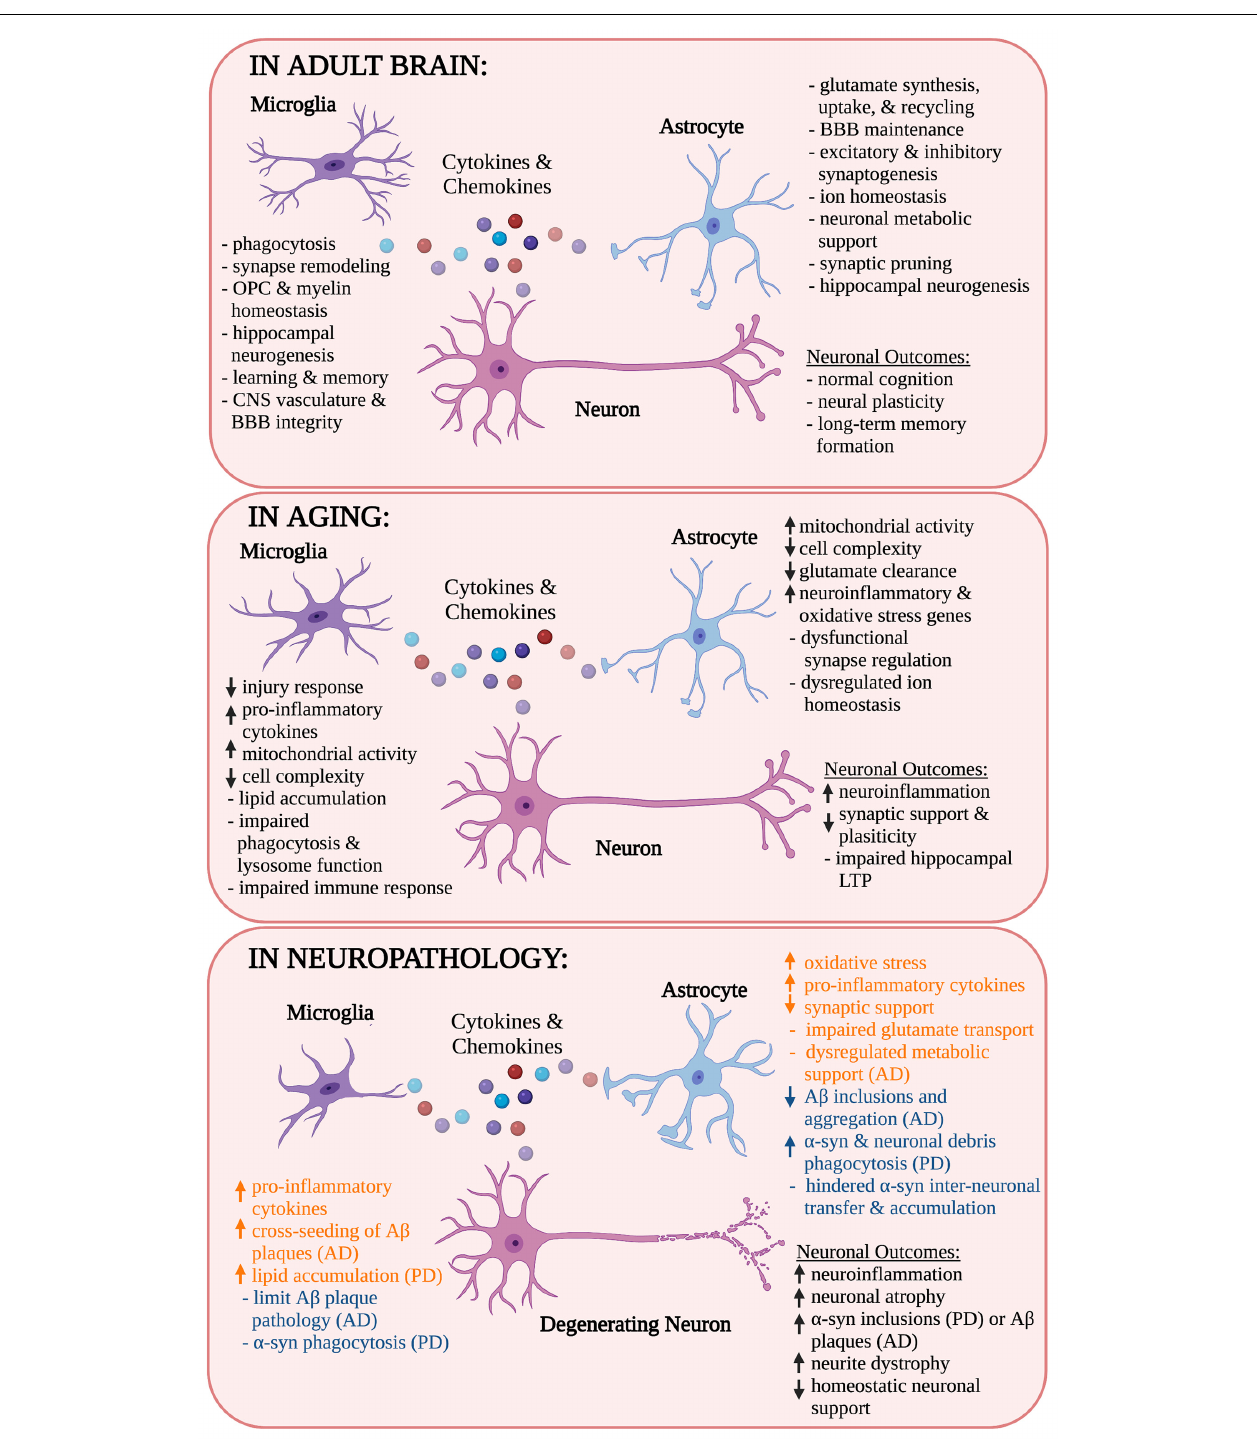
FIGURE 1 | Role of microglia and astrocytes in health, age, and neurodegenerative disease. Microglia and astrocytes release cytokines and chemokines in the neuronal milieu, adopting different responses depending on their surrounding environment. Their responses modulate each other’s activity as well as the activity of neurons and other nearby cell types. In this schematic, the contributions of microglia and astrocytes as well as their influence on neuronal outcomes are identified in health, aging, and neurogenerative disease. Microglial and astrocyte influences in neuropathology are also indicated as pathological (orange) or neuroprotective (blue). OPC, oligodendrocyte progenitor cells; BBB, blood-brain barrier; CNS, central nervous system; LTP, long-term potentiation; A β , amyloid- β ; AD, Alzheimer’s disease; α -syn, α -synuclein; PD, Parkinson’s disease. *Created with Biorender.com.